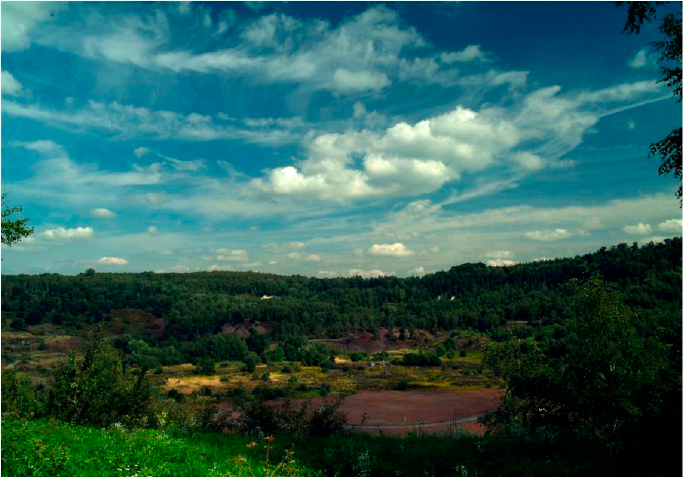
Figure 5. Messel Pit World Heritage Site (WHS), Hesse, Germany—View into fossil site.